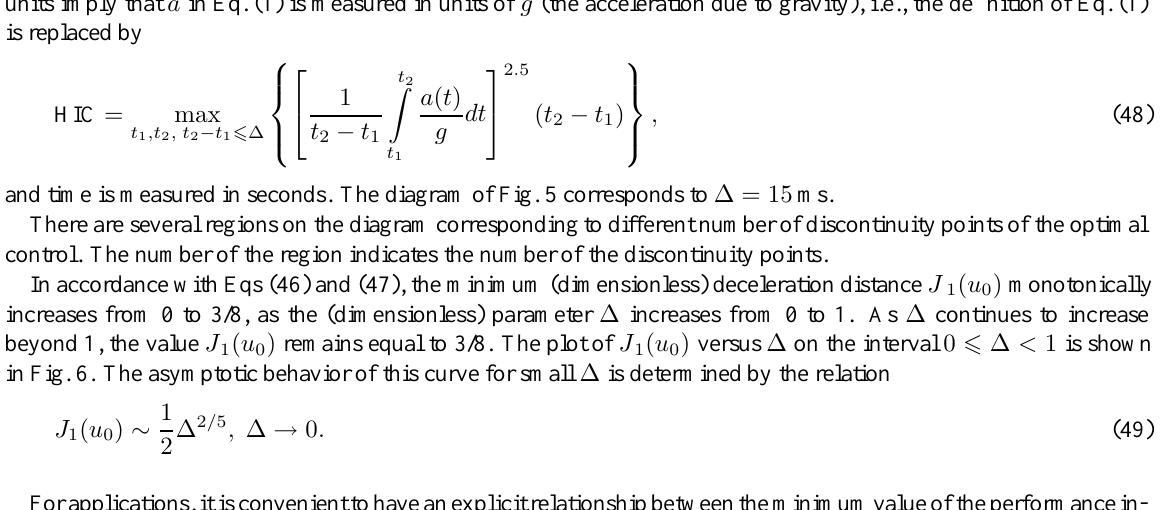
Fig. 5. Curves of constant levels of J 1 ( u 0 ) as a function of v 0 and H . Regions with different numbers of discontinuity points of the optimal control. units imply that a in Eq. (1) is measured in units of g (the acceleration due to gravity), i.e., the definition of Eq.